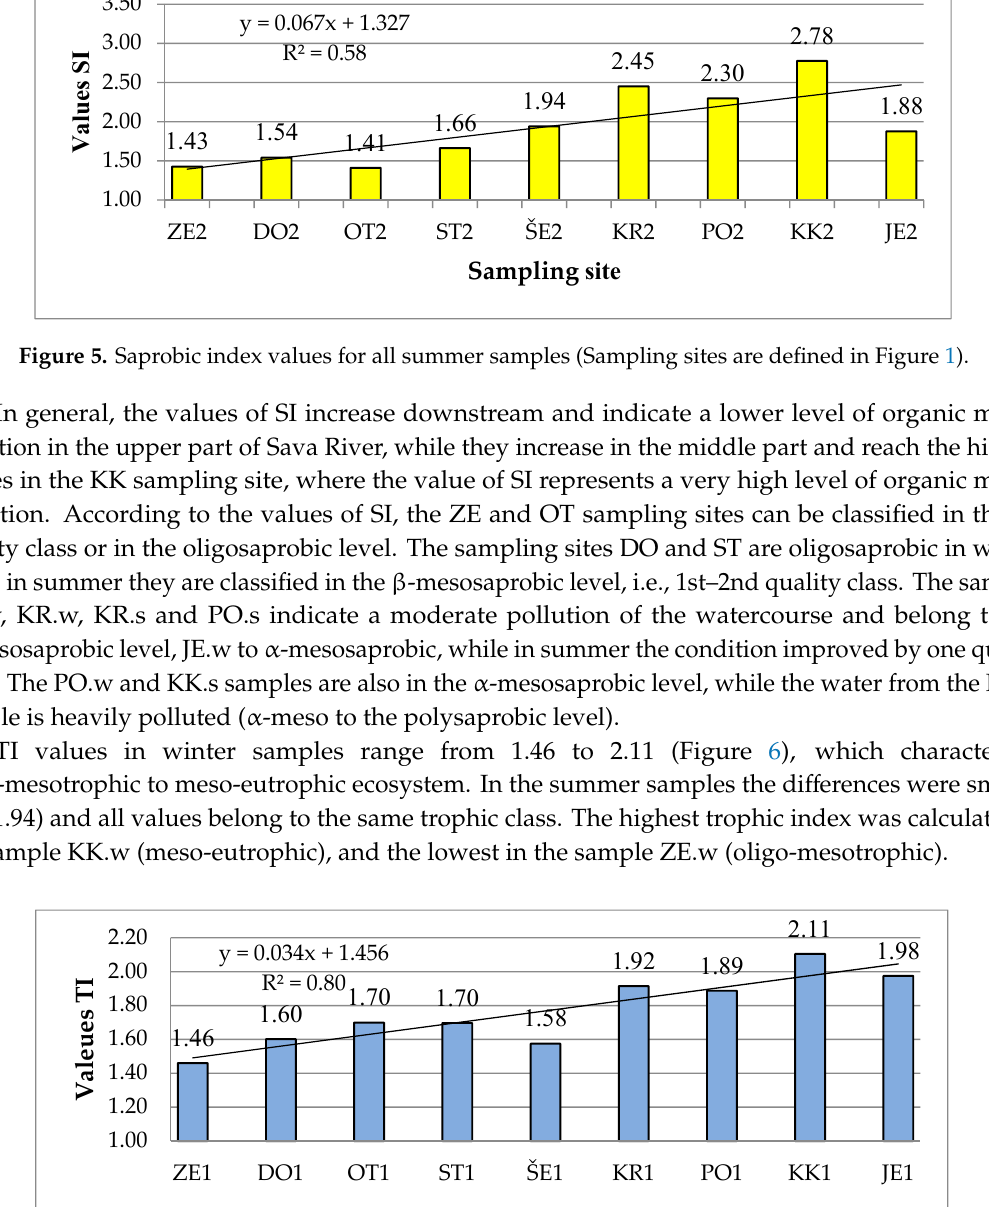
Figure 4. Saprobic index values for all winter samples (Sampling sites are defined in Figure 1).